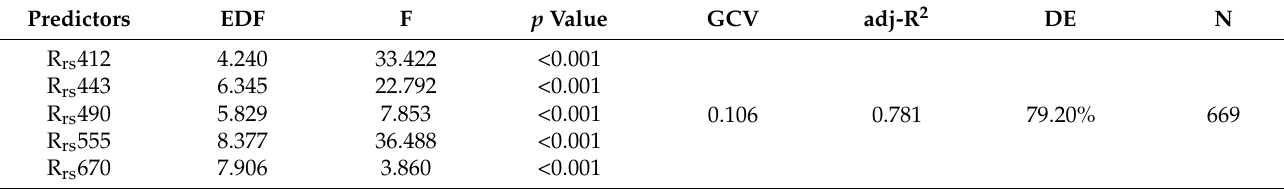
Table 2. Statistical summary of the fitted Chl a GAM. EDF, F, GCV, DE, and N represent the effective degrees of freedom, F statistical value, generalized cross validation, deviance explained, and number of samples, respectively (the same